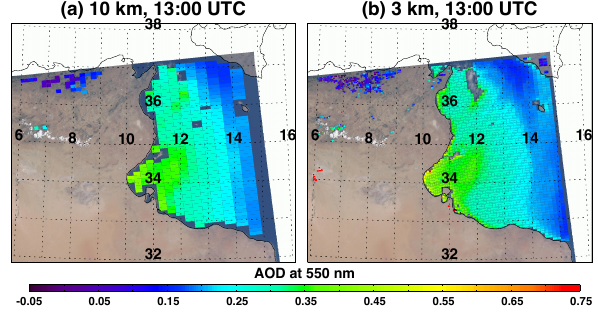
Fig. 4. Same as Fig. 3 but for a situation over Canada where the 3km product better resolves the plume from active wildfires. Note the additional red pixels between the clouds in the upper left corner of the image for the 3km panel.